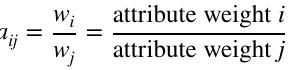
(Table 8). CR can be evaluated by the following formula: